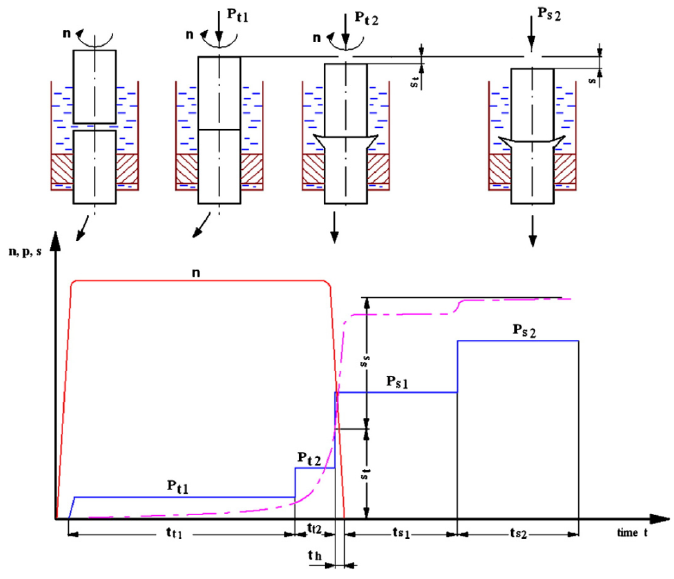
Figure 17. Scheme of friction welding in IME82 oil [45].